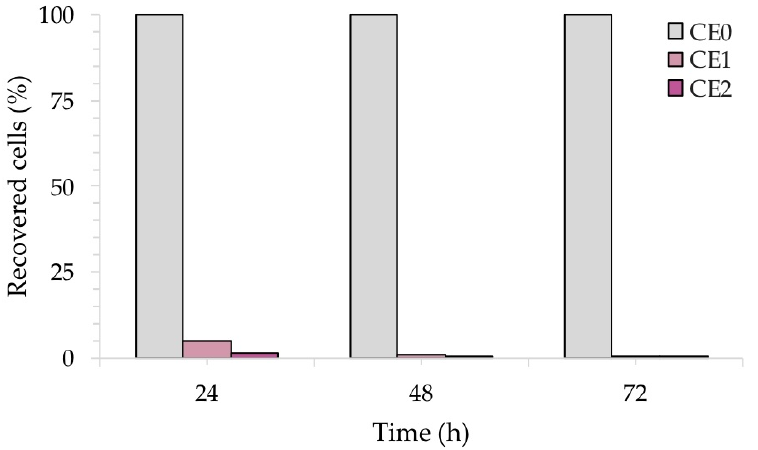
Figure 11. Antifungal activity of the test surfaces against C. albicans after 24, 48 and 72 h of expo-